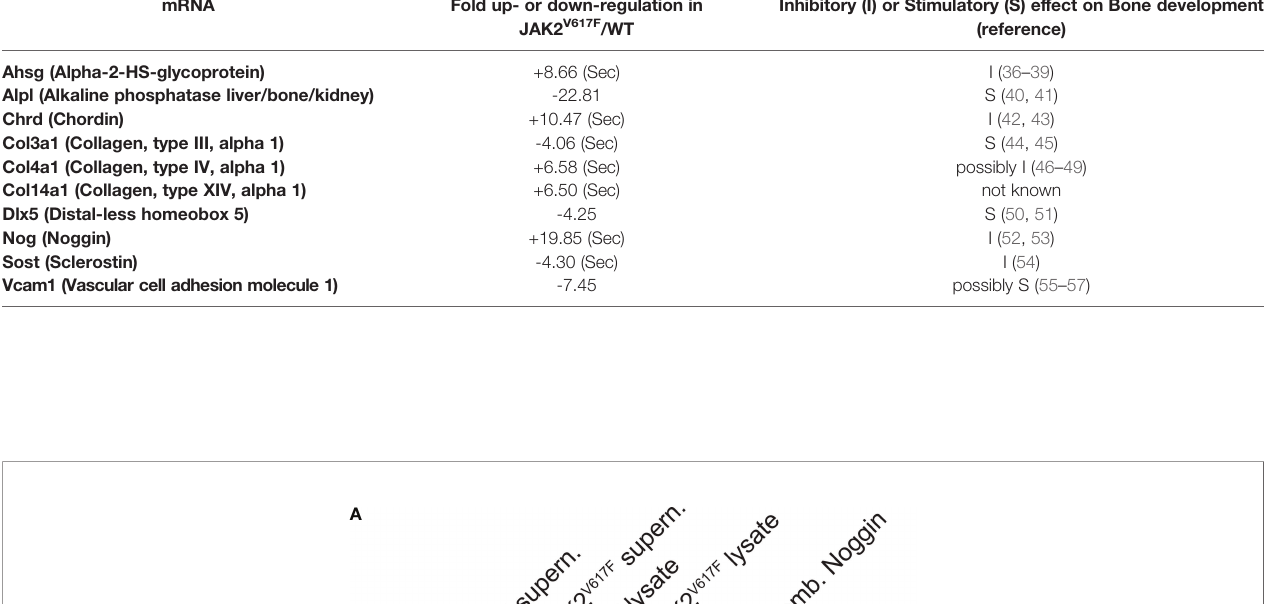
TABLE 1 | Fold up ( “ + ” )- or down ( “ - ” )-regulation of bone-regulating mRNA transcripts in JAK2 V617F MKs vs. WT MKs. mRNAs with a JAK2 V617F /WT ratio ≥ 4 are included. (Sec) denotes a secreted protein.